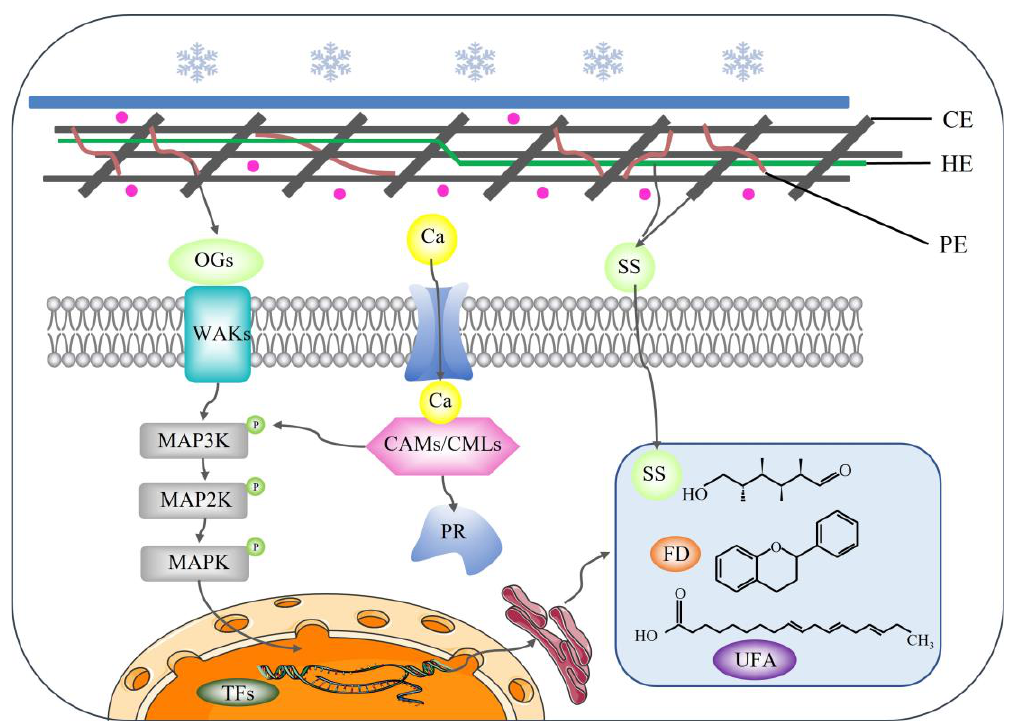
Figure 9. Hypothetical model of DEG expression events in grapevine responding to freezing stress. CE: cellulose; HE: hemicellulose; PE: pectin; OGs: oligogalacturonic acid; WAKs: cell wall-associ- ated kinases; PR: pathogenesis-related protein; TFs: transcription factors; SS: soluble sugar; FD: fla- vonoids; UFA: unsaturated fatty acid.